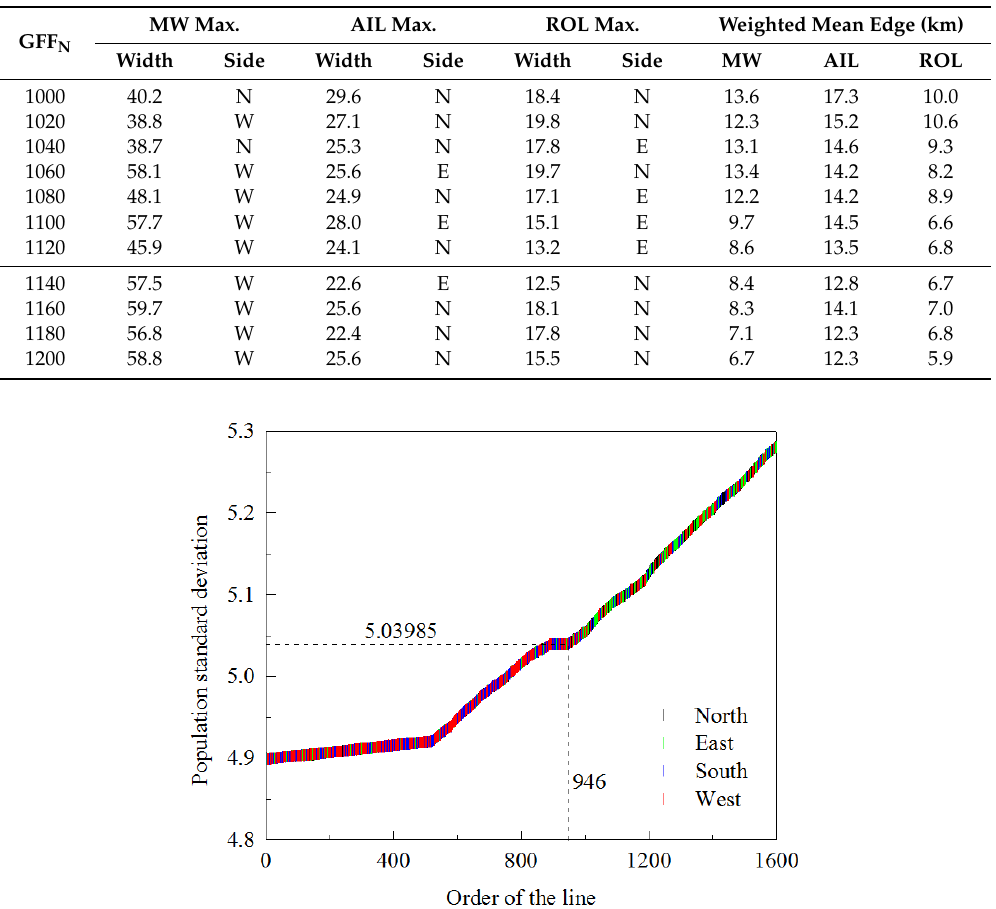
Figure 8. The edge effect region (EER) with reduced fire frequency identified by the agglomeration of inner lines (AIL) method using the grid-level fire frequency map that employed 1200 fire-year maps (GFF 1200 ). Relations are shown between the order in which lines were agglomerated and the population standard deviation of the fire frequency. The color of the vertical line indicates the side of the simulated landscape in which the AIL is located. The dashed line indicates the EER AIL threshold.